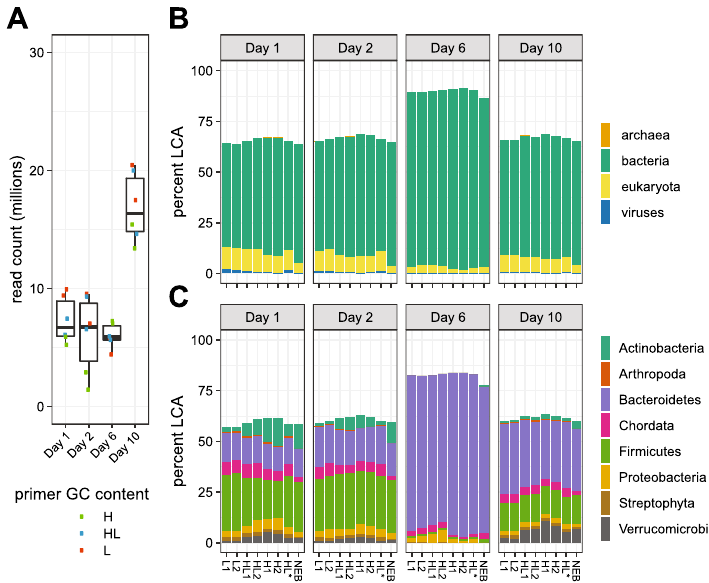
Figure 5. Read composition and taxonomic assignment of ETEC metagenome libraries. ( A ) Raw read counts of Riptide libraries using metagenomic samples. Variability of sequencing throughput was assessed by examining the distribution of read counts per metagenome sample. Members of a read pair were counted as two reads. Circles denote individual values. Libraries are grouped along the x-axis by sample source. The colors of circles correspond to GC primer used in library preparation: L = low GC, HL = 1:1 high:low GC, H = high GC. ( B , C ) Taxonomic classification of reads from ETEC metagenomic samples. Classification of reads from ETEC metagenomic samples was performed using kraken2 with NCBI NT as the reference database. Samples are organized along the x-axis by GC primer used in library preparation, L = low GC, HL = 1:1 high:low GC, H = high GC. Mock high:low datasets were constructed by combining high and low GC datasets for each sample (HL*). NEBNext Ultra libraries were also prepared for each sample (NEB). The lowest common ancestor (LCA) was determined for each read in the dataset, after which percentages of reads corresponding to various taxonomic ranks were obtained. ( B ) Reads were classified at the Domain rank. ( C ) Reads were classified at the Phylum rank, filtered to include those with > 0.5% total reads